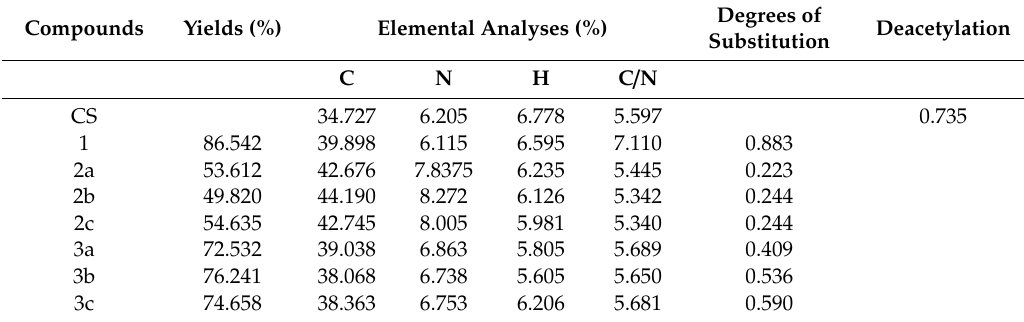
Table 1. Yields and the degrees of substitution of chitosan derivatives.